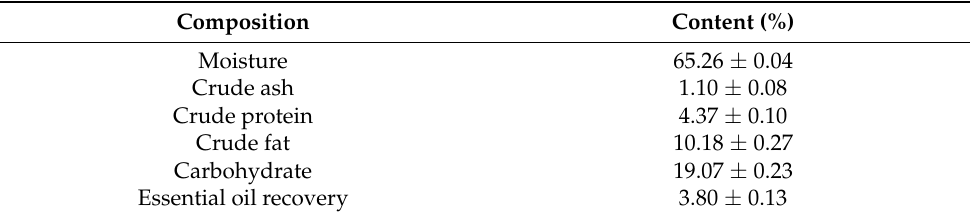
Figure 1. The conceptual framework of experiments for ameliorate memory and learning ability of LCP powder in the mouse model. Table 1. Proximate compositions and essential oil content of Litsea cubeba Persoon fruit.